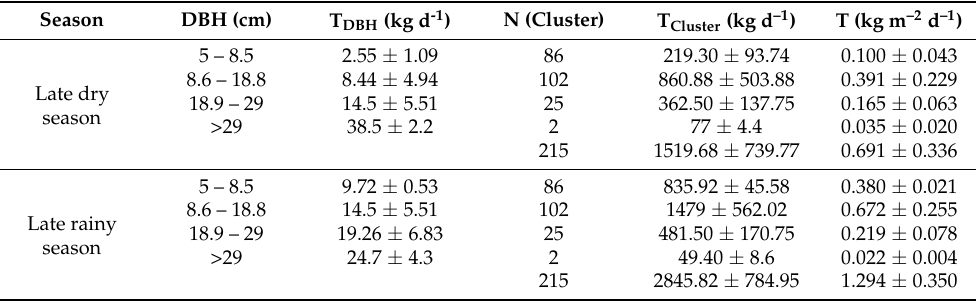
Table 3. Estimated transpiration in the tropical dry deciduous forest using DBH categories (T DBH ), cluster transpiration (T Cluster ), and estimated aerial transpiration (kg m –2 d –1 ). N is the number of trees in the cluster. Cluster area: 2200 m 2 . The late dry season corresponds to March–April; the late